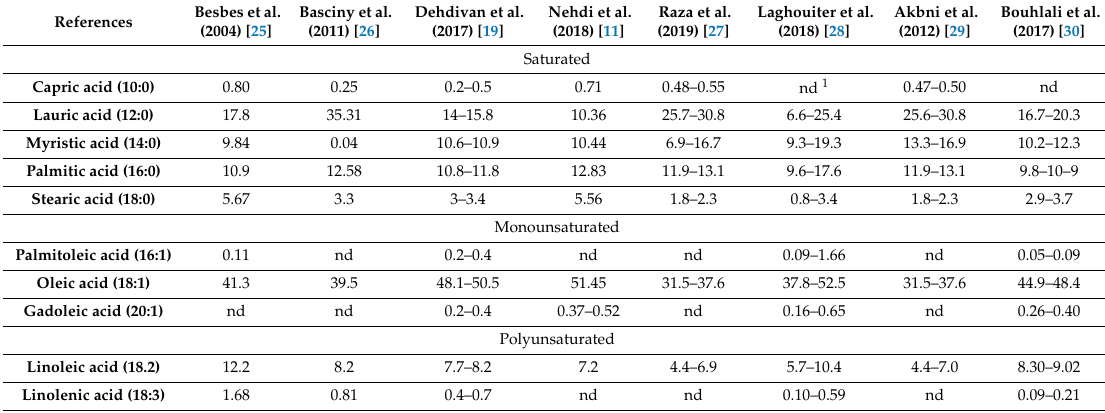
Table 1. Fatty acid profiles of date seed oil expressed as percentage of total fatty acid